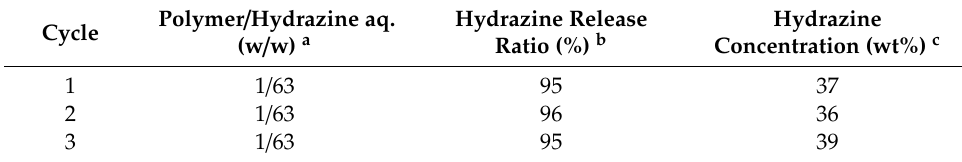
Table 5. Recycling of P(NIPAM- co -AM) gelator for 35wt% hydrazine in releasing by heating at 90 ◦ C for 5 min. Polymer / Hydrazine aq. Hydrazine Release Hydrazine Cycle (w / w) a Ratio (%) b Concentration (wt%) c 1 1 / 63 95 37 2 1 / 63 96 36 3 1 / 63 95